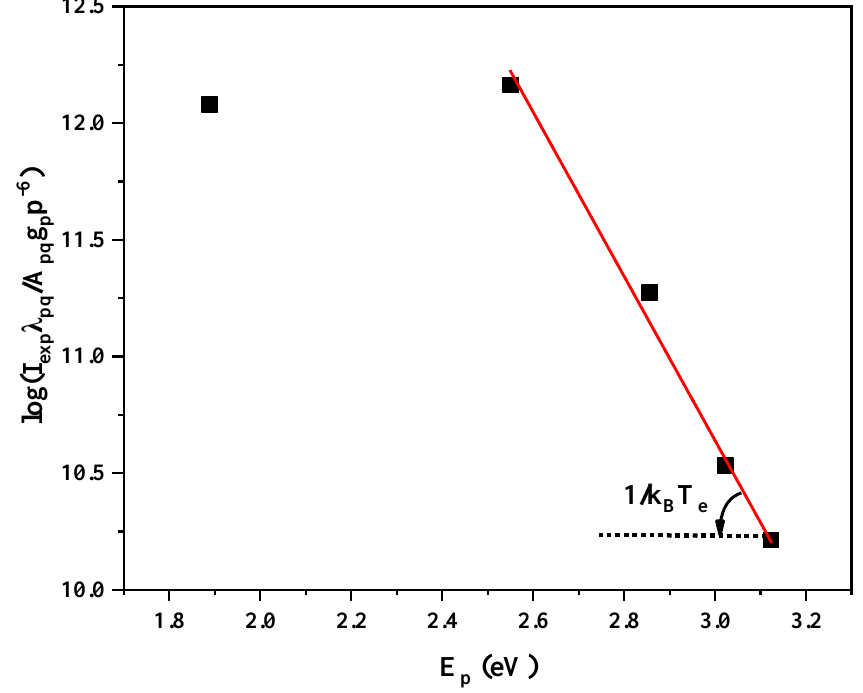
Figure 12. Modified Boltzmann plot of hydrogen lines vs. energy of the departure level p for applied voltage of 14 kV, rotation frequency of the power electrode of 18,000 rpm, and the gas flowrate of 1 sLm.